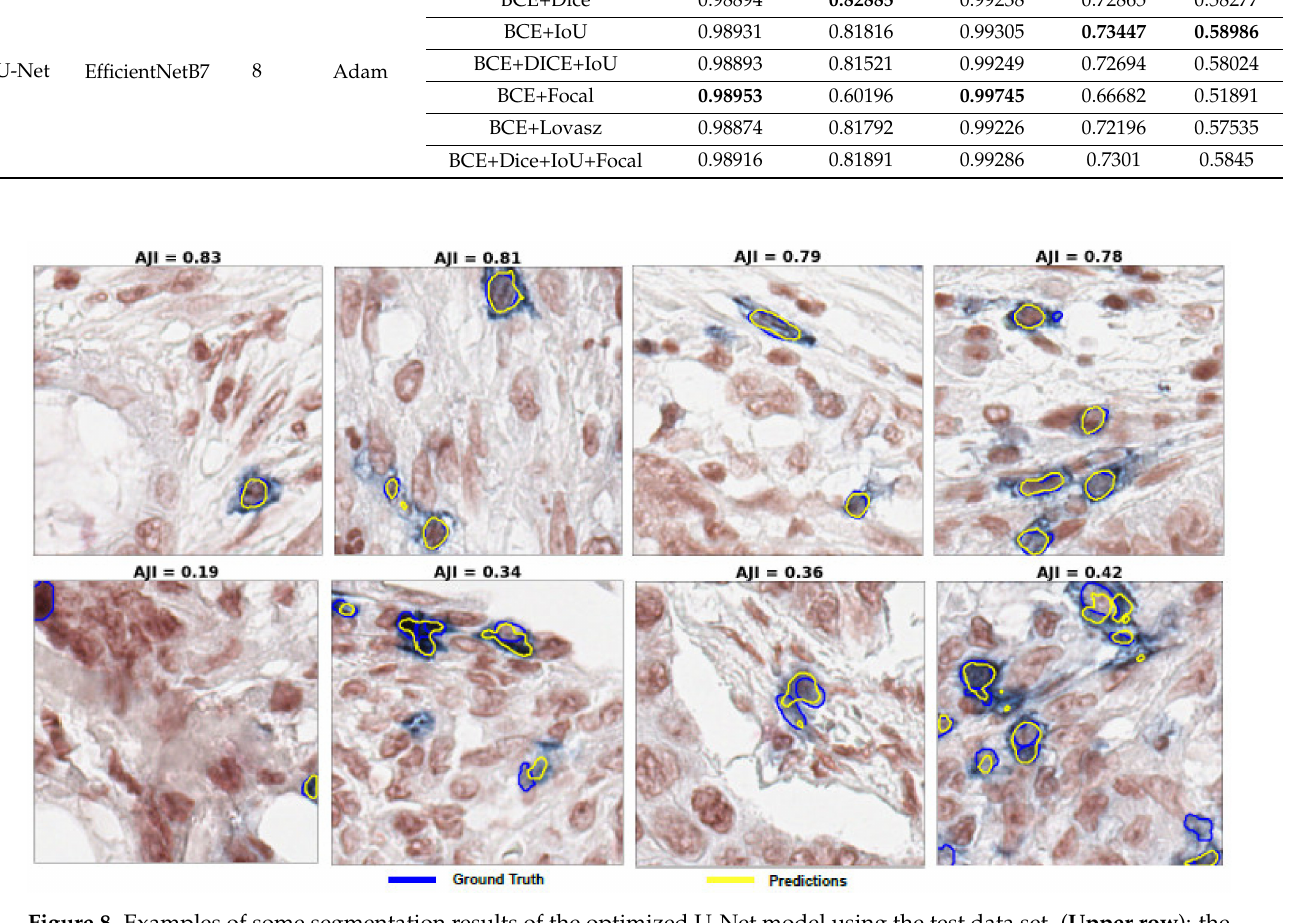
Figure 8. Examples of some segmentation results of the optimized U-Net model using the test data set. ( Upper row ): the best performance of the model. ( Lower row ): the poor performance of the model. Note that, the blue and yellow colours represent the annotated ground-truth and the best model predictions,